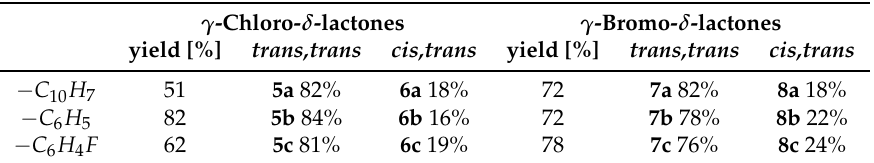
Figure 1. A four-step synthesis of γ -halo- δ -lactones and δ -hydroxy- γ -lactones. Table 1. The yields and products distribution from halolactonization of unsaturated carboxylic acids 4a – c (according to